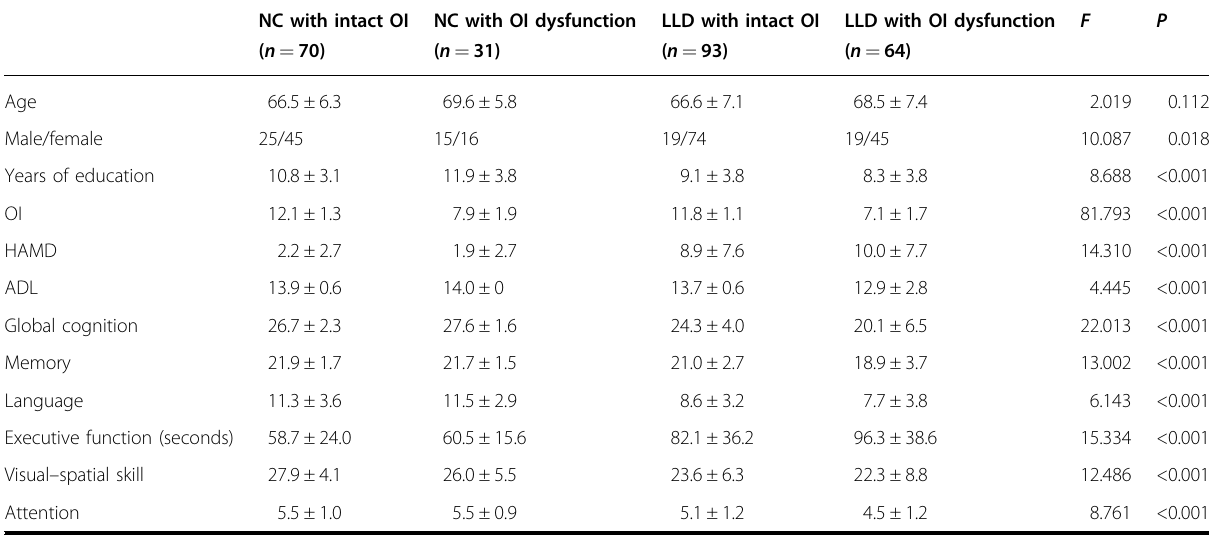
Table 1 Demographic, olfactory, and neuropsychological information of all